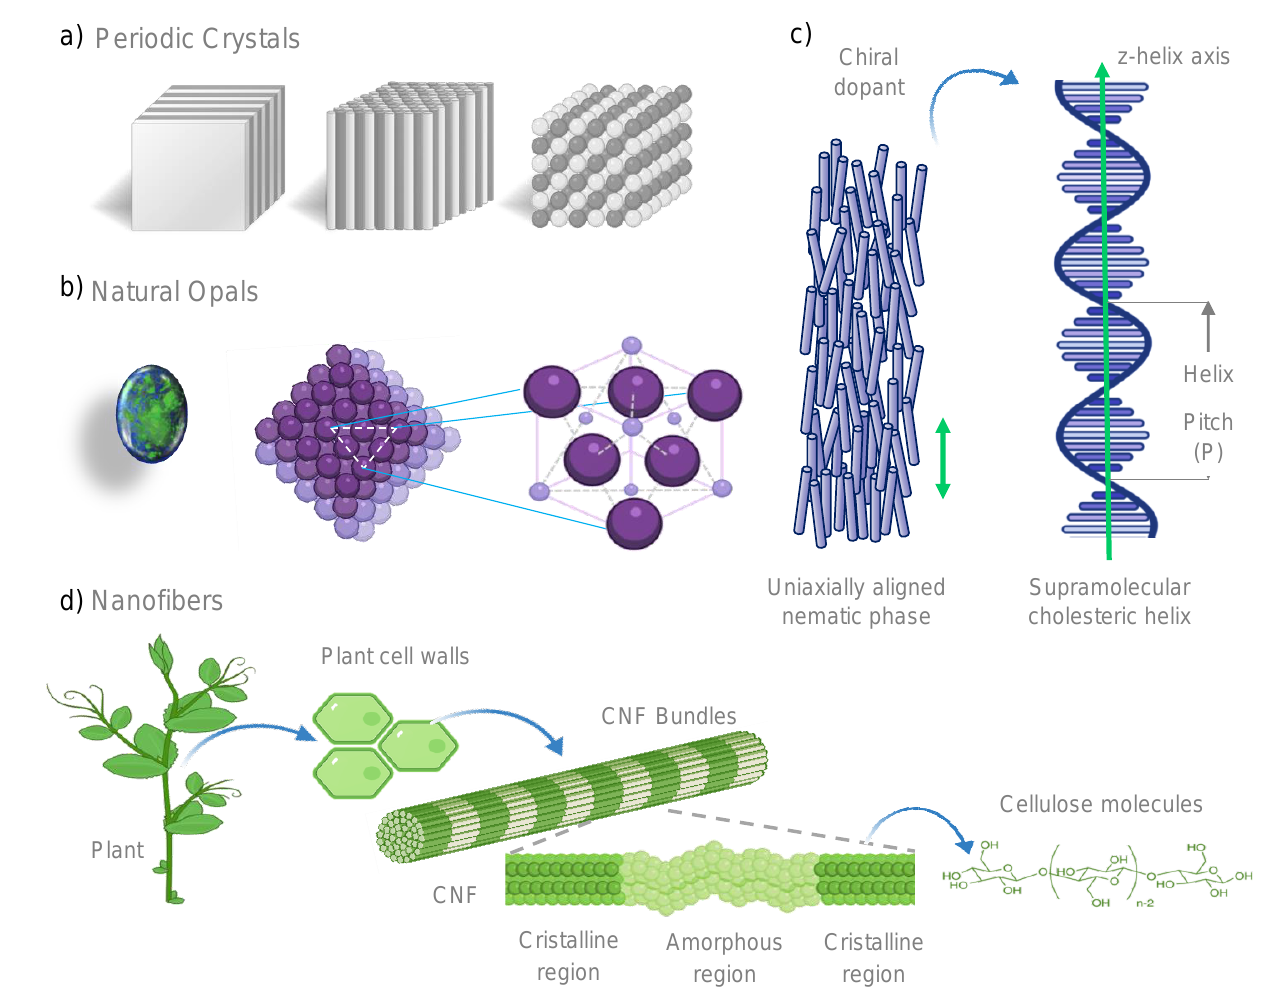
Figure 1. ( a ) One dimensional (1D), 2D, and 3D organization of photonic crystals, found in